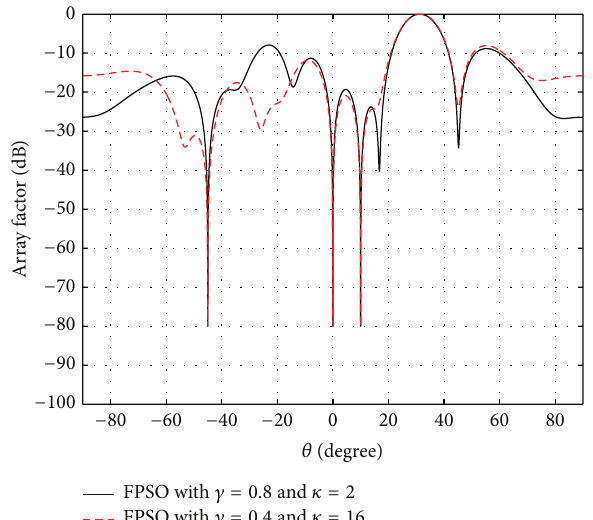
FPSO with 𝛾 = 0.8 and 𝜅 = 2 FPSO with 𝛾 = 0.4 and 𝜅 = 16 Figure 2: Resultant beam pattern designed ( 𝑁 = 10 ) by the feed- back function of (8) with 𝛾 = 0.8 , 𝜅 = 2 and 𝛾 = 0.4 , 𝜅 = 16